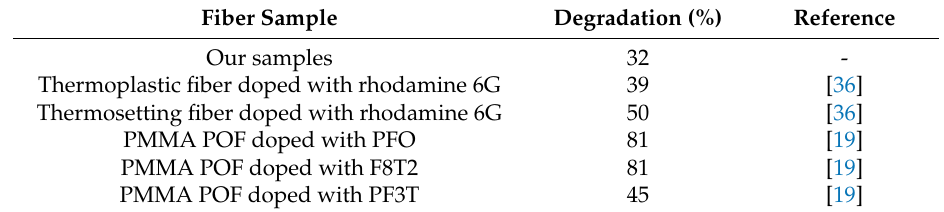
Figure 10. Fluorescence intensity as a function of the excitation time in our POF samples doped at 10 °C. The excitation wavelength was 520 nm, the excitation irradiance was 22 nJ/cm 2 , and the light propagation distance was 4 cm. Table 2. Percentage rate of degradation of the fluorescence intensity for several doped fibers under the same excitation conditions: 60 min of excitation with 22 nJ/cm 2 of irradiance.